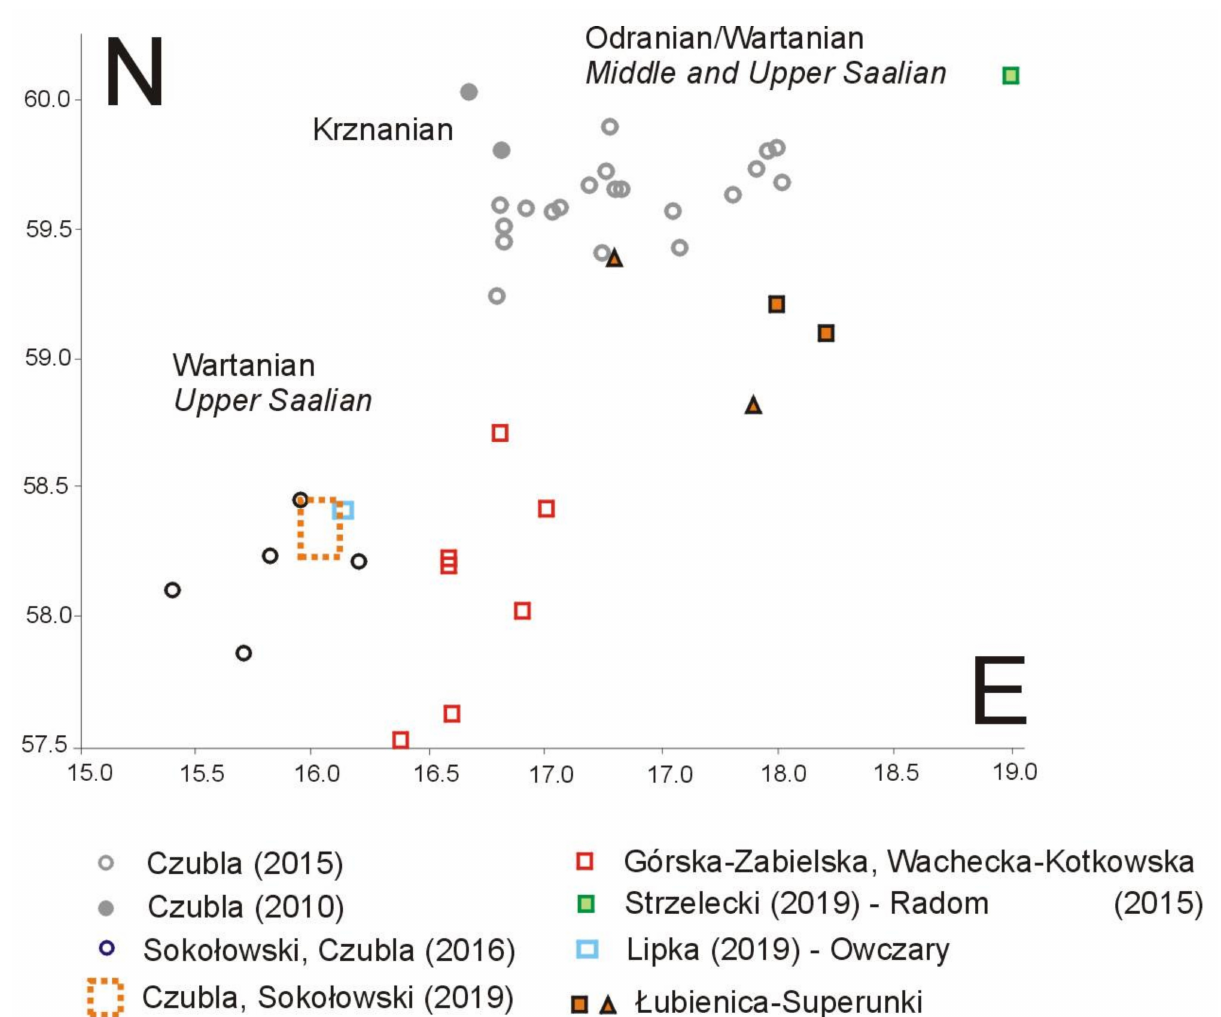
Figure 11. Theoretical boulder centres (TBC) of indicator erratics in Łubienica-Superunki against others calculated in central Poland by listed authors, according to certain ice sheet advances. Krznian—MIS8,